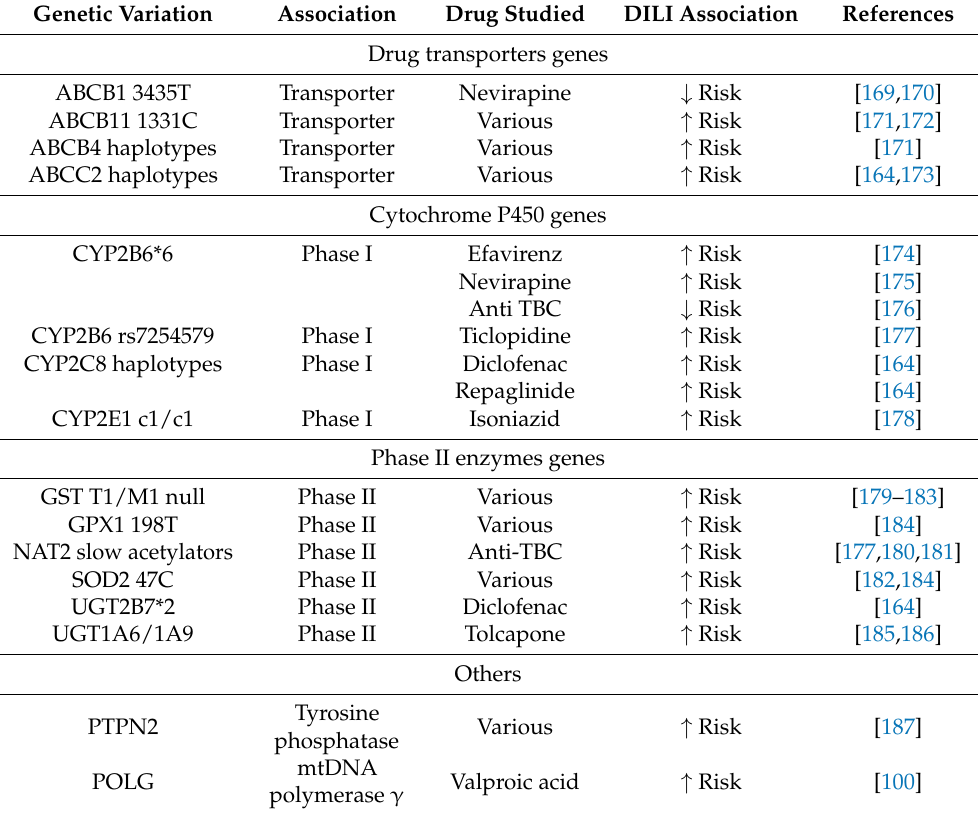
Table 2. List of genetic polymorphisms related to susceptibility of DILI